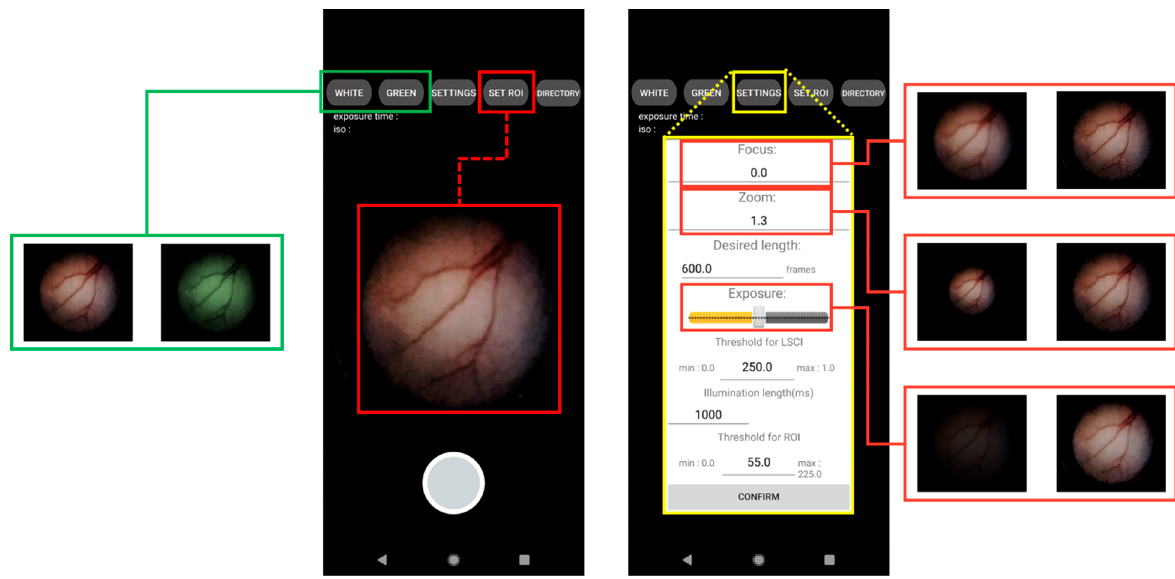
Figure 2. Android-based user-interface software for the smartphone LSCI endoscope device.